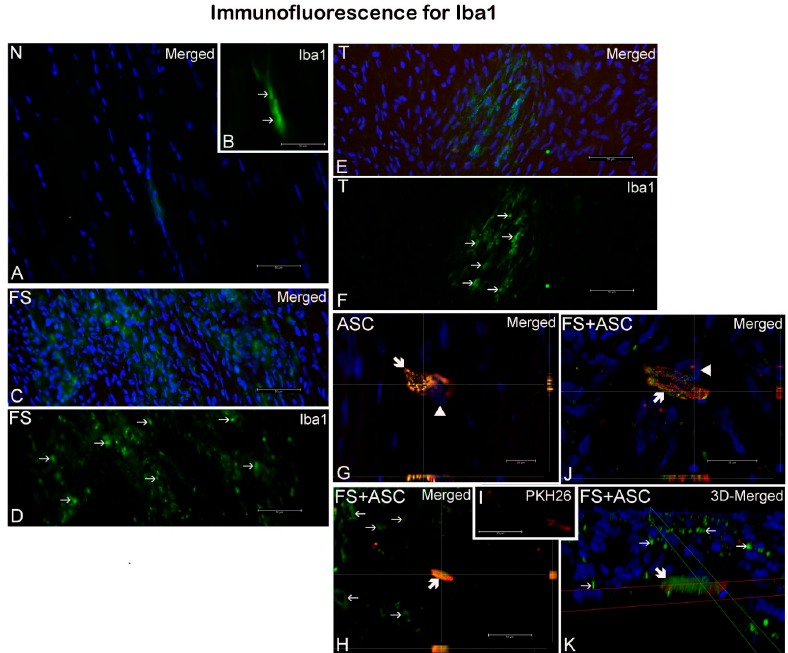
Figure 5. Iba1 labeled macrophages (green, ) were observed in all tendons ( n = 3) regardless the